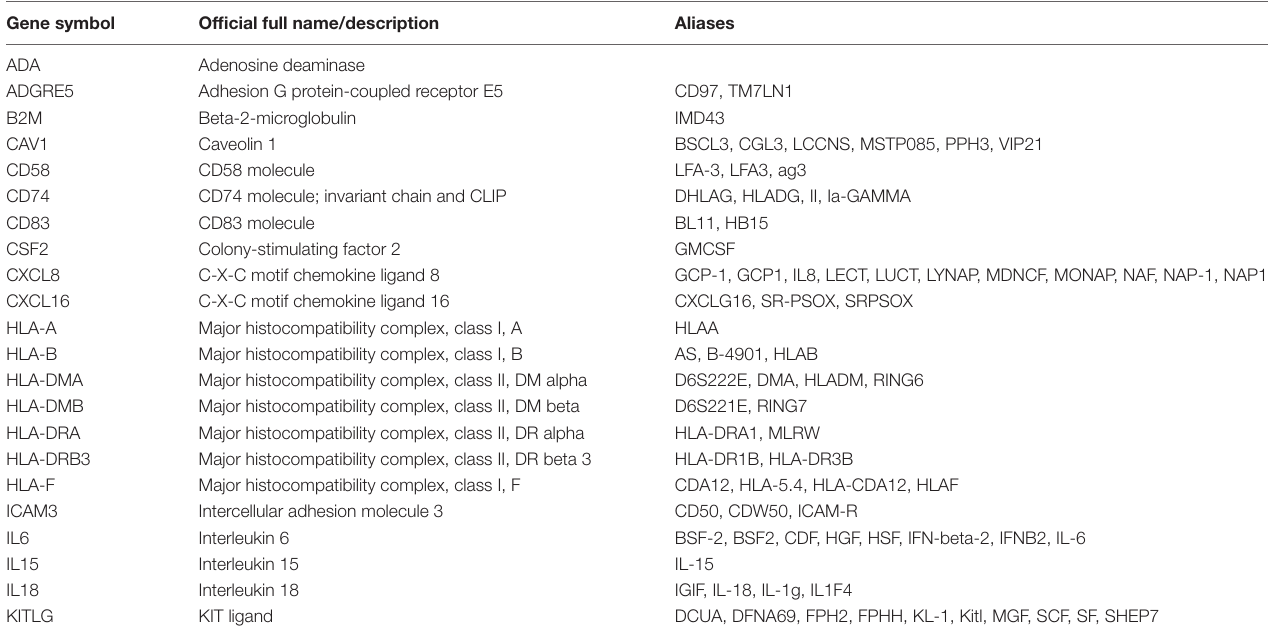
TaBle 1 | 22-gene Immune Signature expressed in SV-BR-1-GM